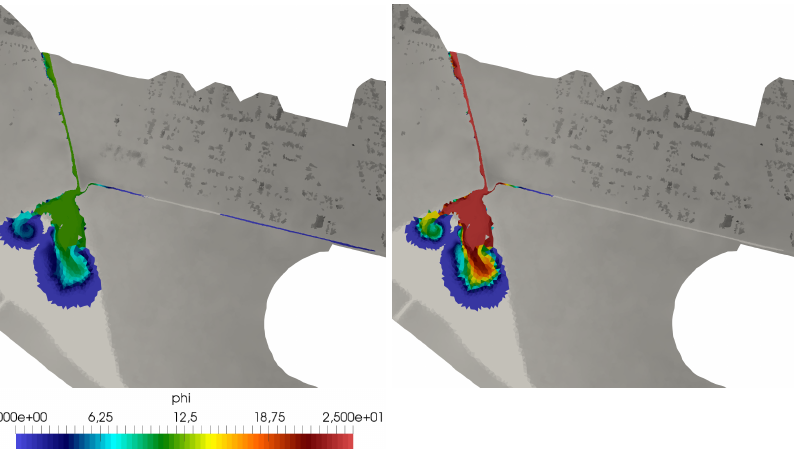
Figure 19. Case 3: Detail of the surface-sewer connecting channel showing the pollutant concentration for both solutes φ 1 ( left ) and φ 2 ( right ) at t = 1.8